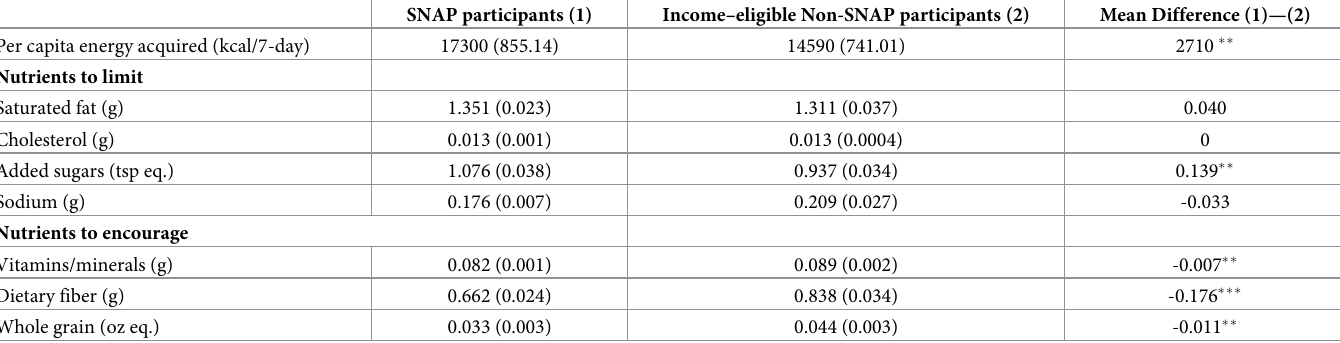
Table 4. Comparison of per capita energy acquired (kcal) and nutrients densities (per 100 kcal of FAH purchases) between SNAP and low-income non-SNAP